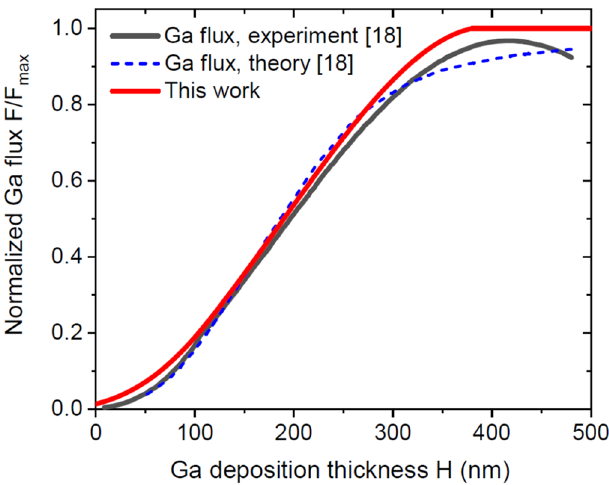
Figure 6. Normalized Ga current versus Ga deposition thickness. The bold black curve corresponds to the data of Ref. [18], obtained by monitoring the axial growth, radial extension, and increase in the Ga droplet volume in a self-catalyzed VLS GaP NW. The dashed blue line shows the modeling results of Ref. [18]. The bold red line is given by Equations (2) and (4) at a fixed 𝛽 of 135° using the dependences of the NW length and radius on 𝐻 described in the main text.